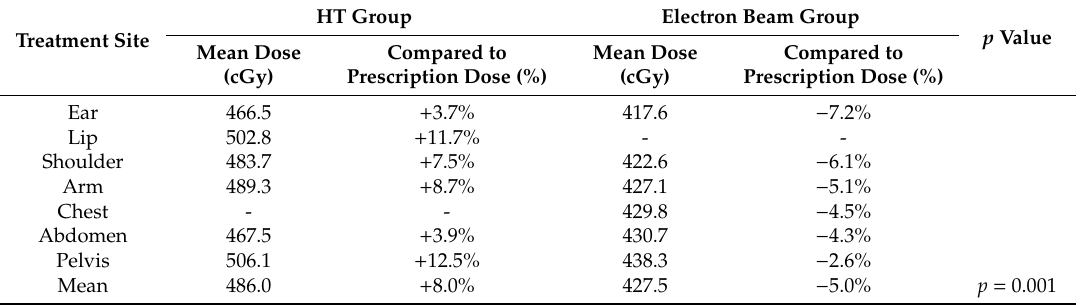
Table 3. Surface doses delivered to the skin for patients with keloids treated with helical tomotherapy (HT) or electron beam irradiation (13.5 Gy in 3 fractions) as measured with radiochromic EBT3 film. Treatment